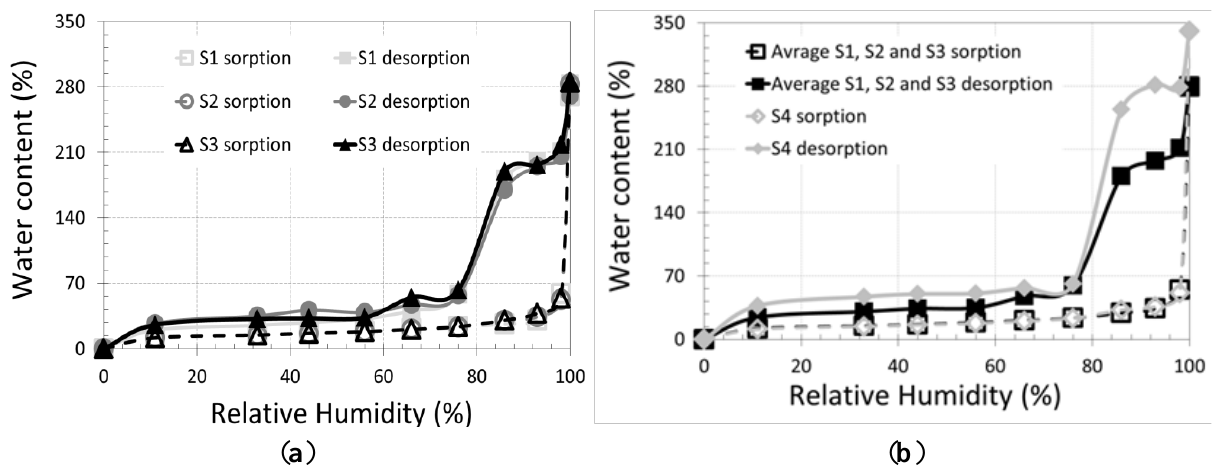
Figure 4. Sorption-desorption isotherms ( a ) 3 types of wheat straw; ( b ) comparison of wheat and barley